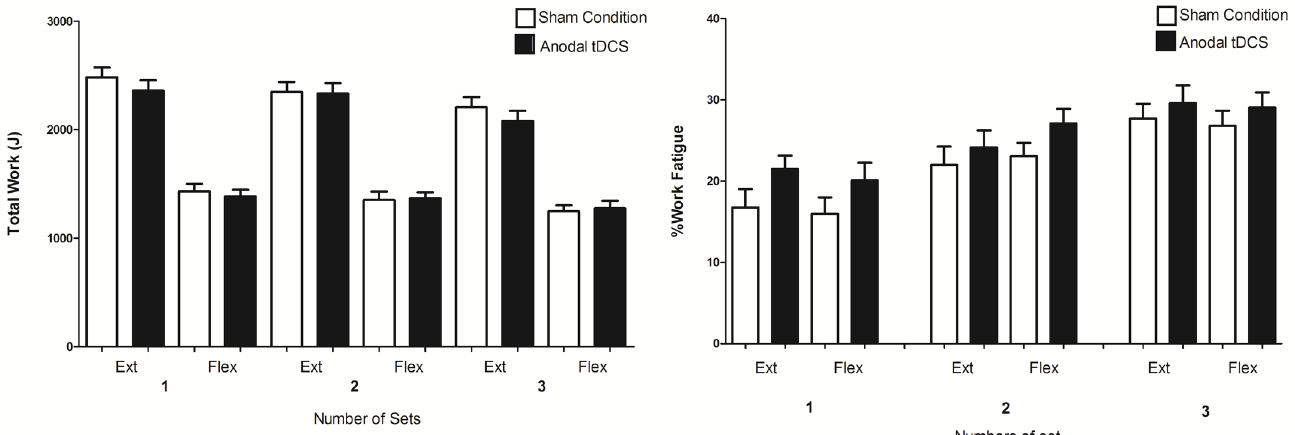
Figure 2. Mean ± SD values of total work (left side) and work fatigue percentage (right side) within maximal isokinetic strength exercise after sham and anodal tDCS ( n =14). 2-way ANOVA with repeated measures did not detected significant differences between anodal and sham tDCS for total work (P = .32) and work fatigue percentage ( P = .67). tDCS = Transcranial direct current stimulation. Ext = Extension muscular phase; Flex = Flexion muscular